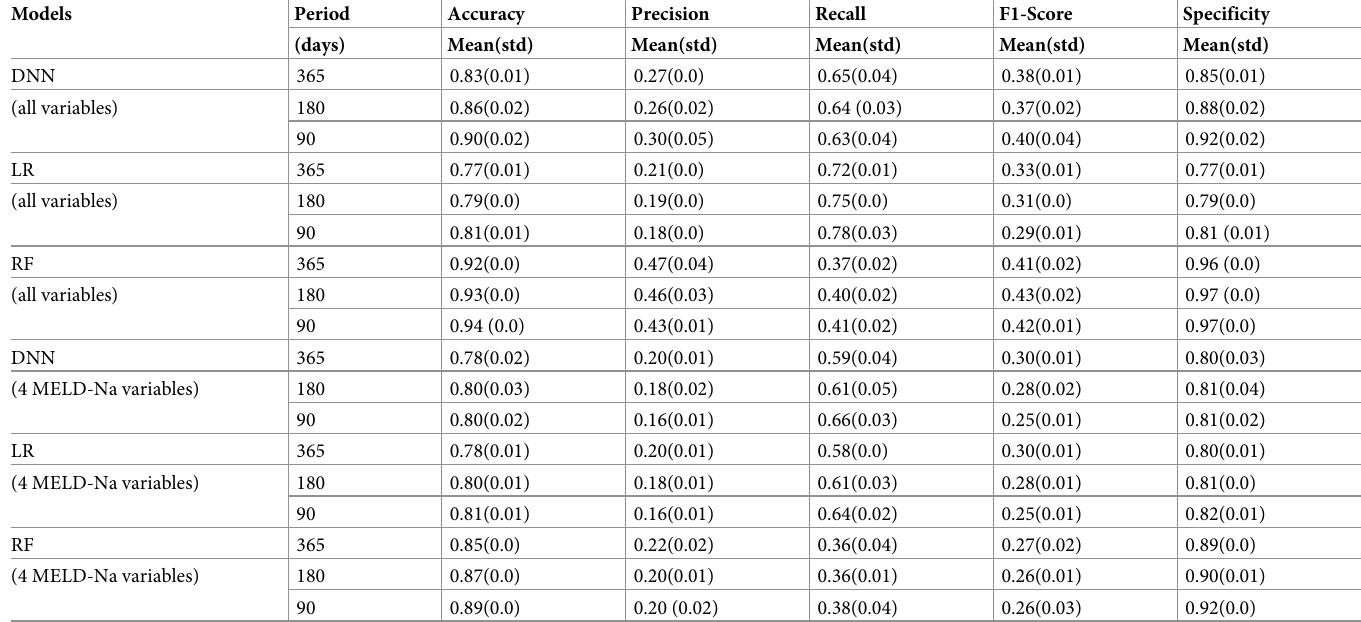
Table 2. Prediction metrics [n (%)] of 3 period cases for 3 machine learning